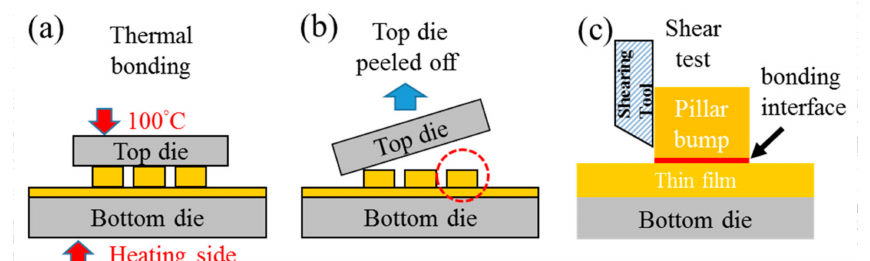
Figure 1. The schematic drawings show the experimental procedures. ( a ) Cu-to-Cu direct bonding, ( b ) top die peeled off, and ( c ) shear tests of Cu joint.